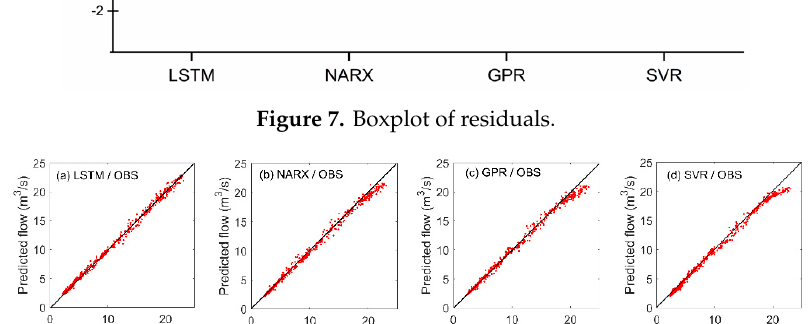
Figure 7. Boxplot of residuals.